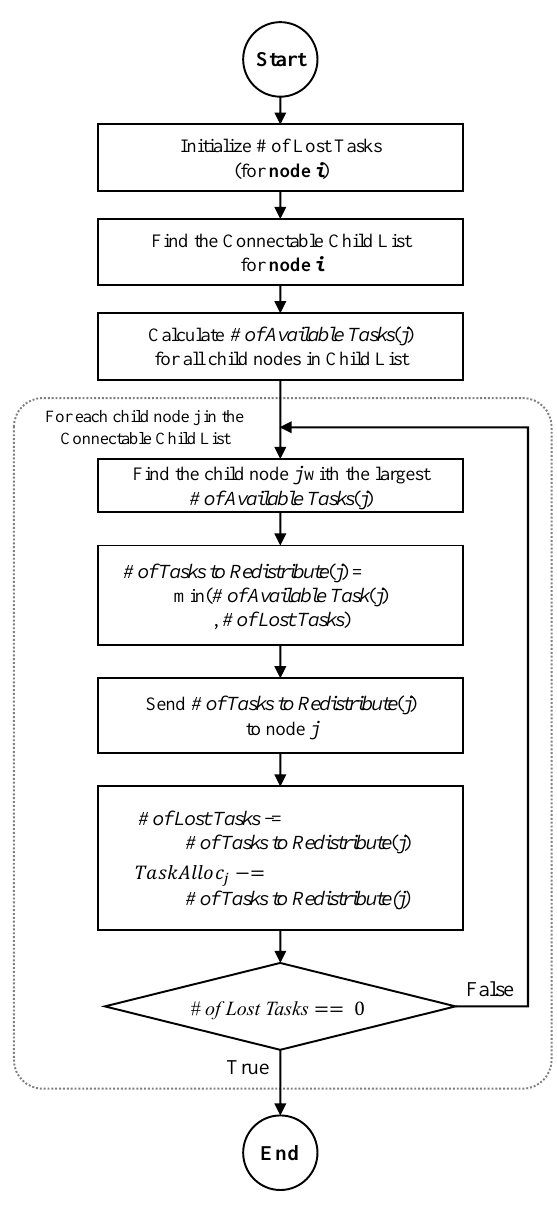
Figure 7. Flowchart of a task redistribution